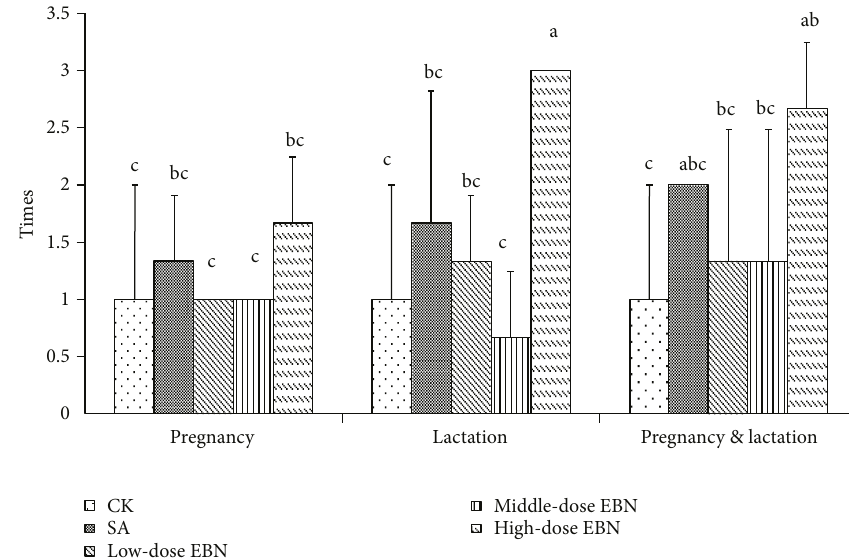
Figure 4: Times for which 10 cubs of each group crossed the target area after treated with edible bird ’ s nest (EBN) homogenate in di ff erent doses. Signi fi cant di ff erences were indicated by di ff erent letters for each group ( P < 0 05 ).